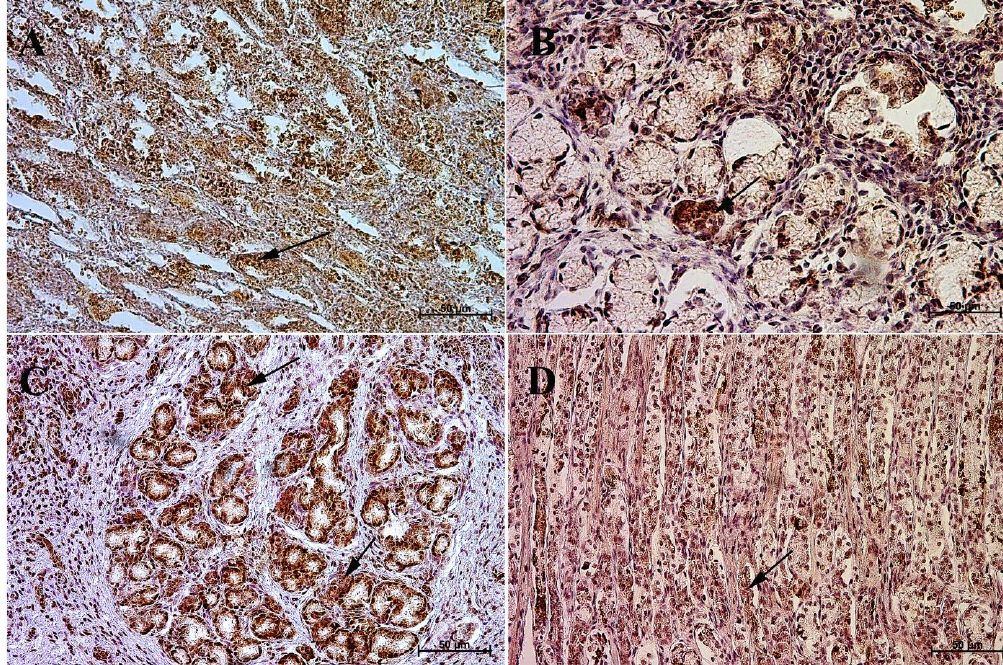
Figure 10. Immunoreactivity of anti-somatostatin antibody in the pyloric mucosa, 40×. ( A ) the first age group, ( B ) the second age group, ( C ) the third age group, ( D ) adult reference group. The arrow indicates positive immunohistochemical reaction. Table 6. Immunoreactivity of anti-somatostatin antibody. The first age group (4 – 5 month of gestation) IRS mean/SD Description